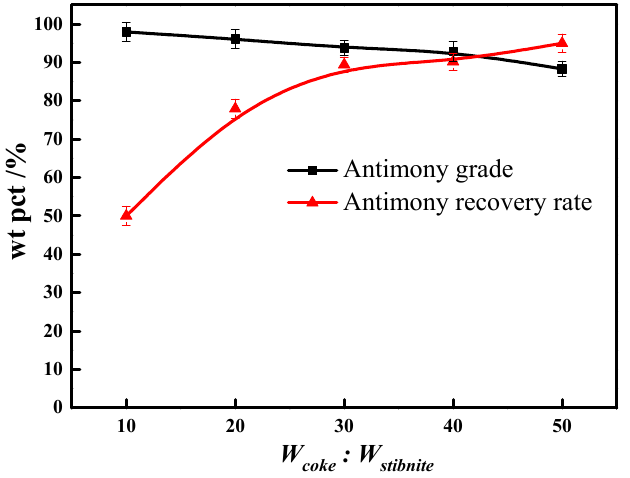
Figure 9. Influence of coke addition on the extraction of antimony and antimony grade. ( α salt = 1.0, W NaCl : W Salt = 40%, α Fe = 1.0, 850 °C (1123 K), 60 min). 2 O 3